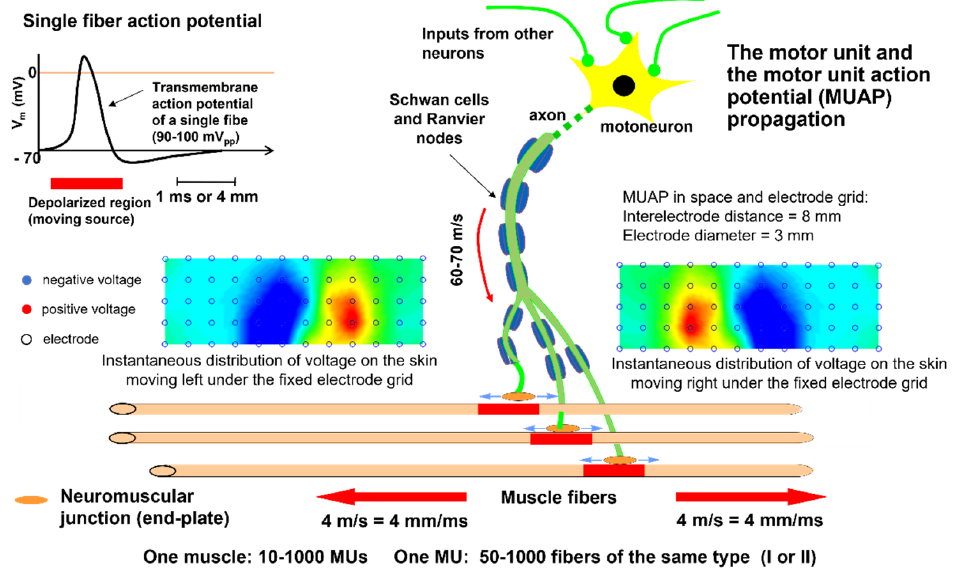
Figure 2. Example of motor unit action potential (MUAP) generation and propagation: electrode grids and maps of the right and left propagating potentials on the skin. Modified from (https://www.robertomerletti.it/en/emg/material/teaching/module5 accessed 10 May 2022, This date applies to all websites and URLs). (See animation in Supplementary Materials, Sup1).